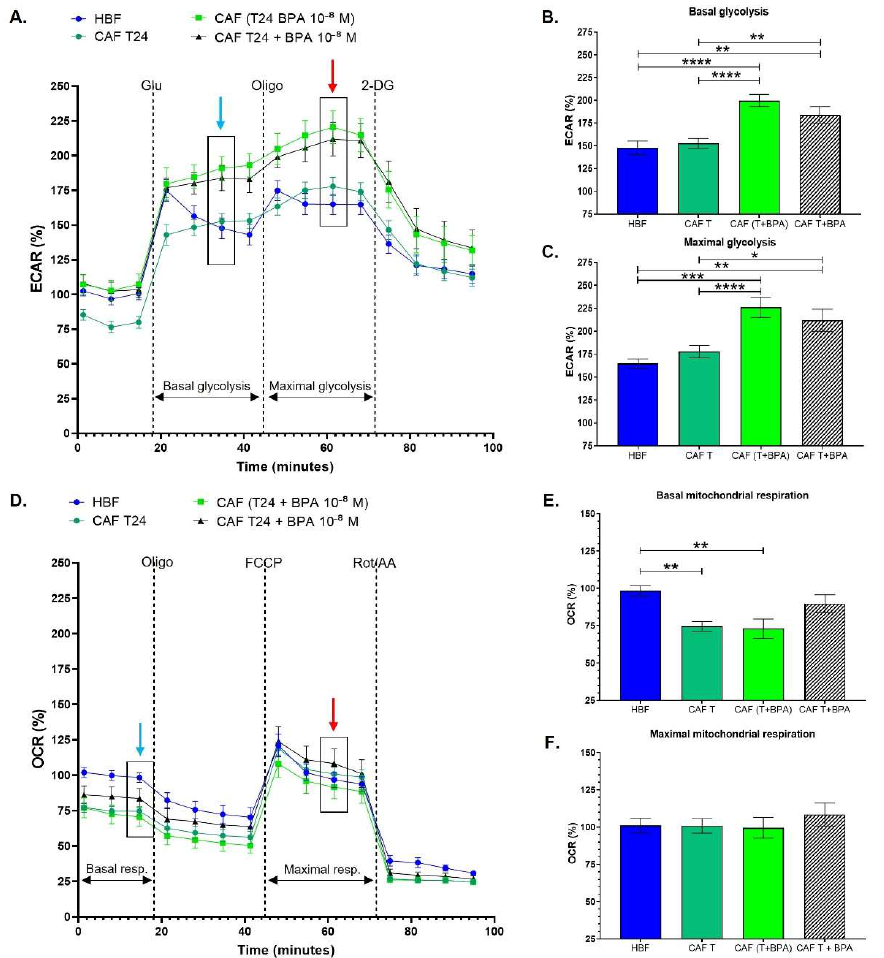
Figure 4. Cancer-associated fibroblasts conditioned with invasive bladder cancer cells in the presence of BPA exhibit an increased glycolytic metabolism. ( A – C ) ECAR and ( D – F ) OCR were determined using the XFe96 Extracellular Flux Analyzer in cancer-associated fibroblasts (CAFs). Healthy human bladder fibroblasts (HBFs) were induced into CAFs over 8 days with conditioned media from invasive cancer cells (T24) with exposure (direct or indirect) or not to 10 −8 M BPA to establish (B) basal glycolysis, ( C ) maximal glycolytic capacity, ( E ) basal mitochondrial respiration and ( F ) maximal mitochondrial capacity. ( A ) The glycolytic metabolism and ( D ) mitochondrial respiration were established using sequential injections, as in Figure 1. Analyses in ( B , C ) were performed using measure #6 (blue arrow) for basal glycolysis and measure #10 (red arrow) for maximal glycolytic capacity. Analyses in ( E , F ) were performed using measure #3 (blue arrow) for basal mitochondrial respiration and measure #10 (red arrow) for maximal mitochondrial respiration. Data are presented as the mean ± SEM and displayed as percentages of controls ( n = 8; N = 3). * p < 0.05, ** p < 0.01, *** p < 0.001 and **** p < 0.0001 by one-way ANOVA. 4. Discussion As plastic products become more and more ubiquitous in our environment, studying the effects of the chemical compounds they can release, such as BPA, has become crucial. Growing evidence has shown the pro-tumorigenic effect of BPA [4–6] in many cancers, especially hormone-dependent cancers such as breast [5] and prostate cancer [7]. Alt- hough bladder tissue is not recognized as a hormone-sensitive tissue, studies have demonstrated the role of hormone receptors in bladder cancer initiation and progression